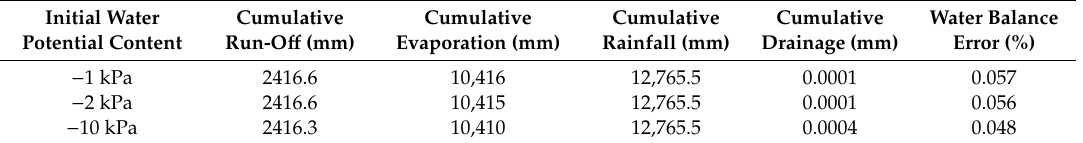
Table 5. The simulated water balance